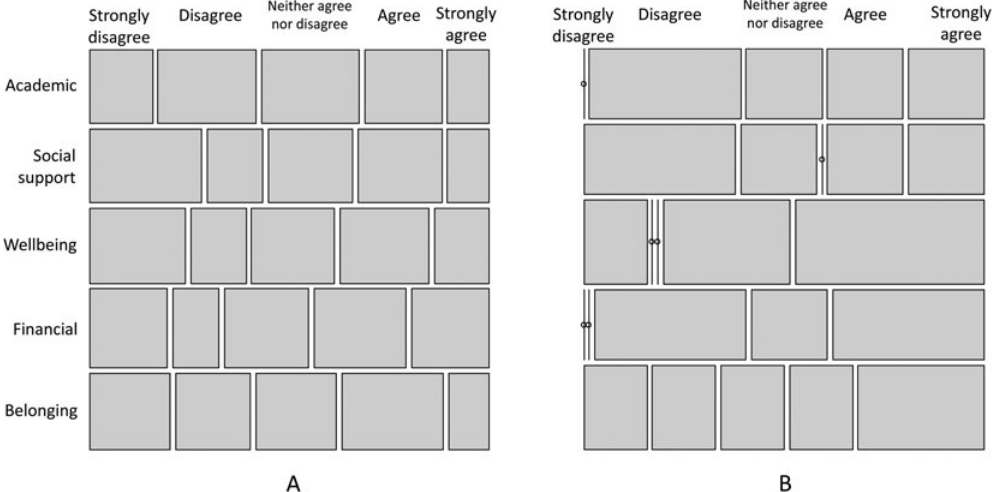
Fig. 2. Mosaic plots representing the (non-significant) association between academic, social, well-being, belonging and financial factors ( y axis) with withdrawal likelihood ( x axis). Mosaic plot A =association between academic, social, well-being, belonging and financial factors and withdrawal likelihood for participants with low likelihood of withdrawing from studies. Mosaic plot B =association between academic, social, well-being, belonging and financial factors and withdrawal like- lihood for participants with high likelihood of withdrawing from